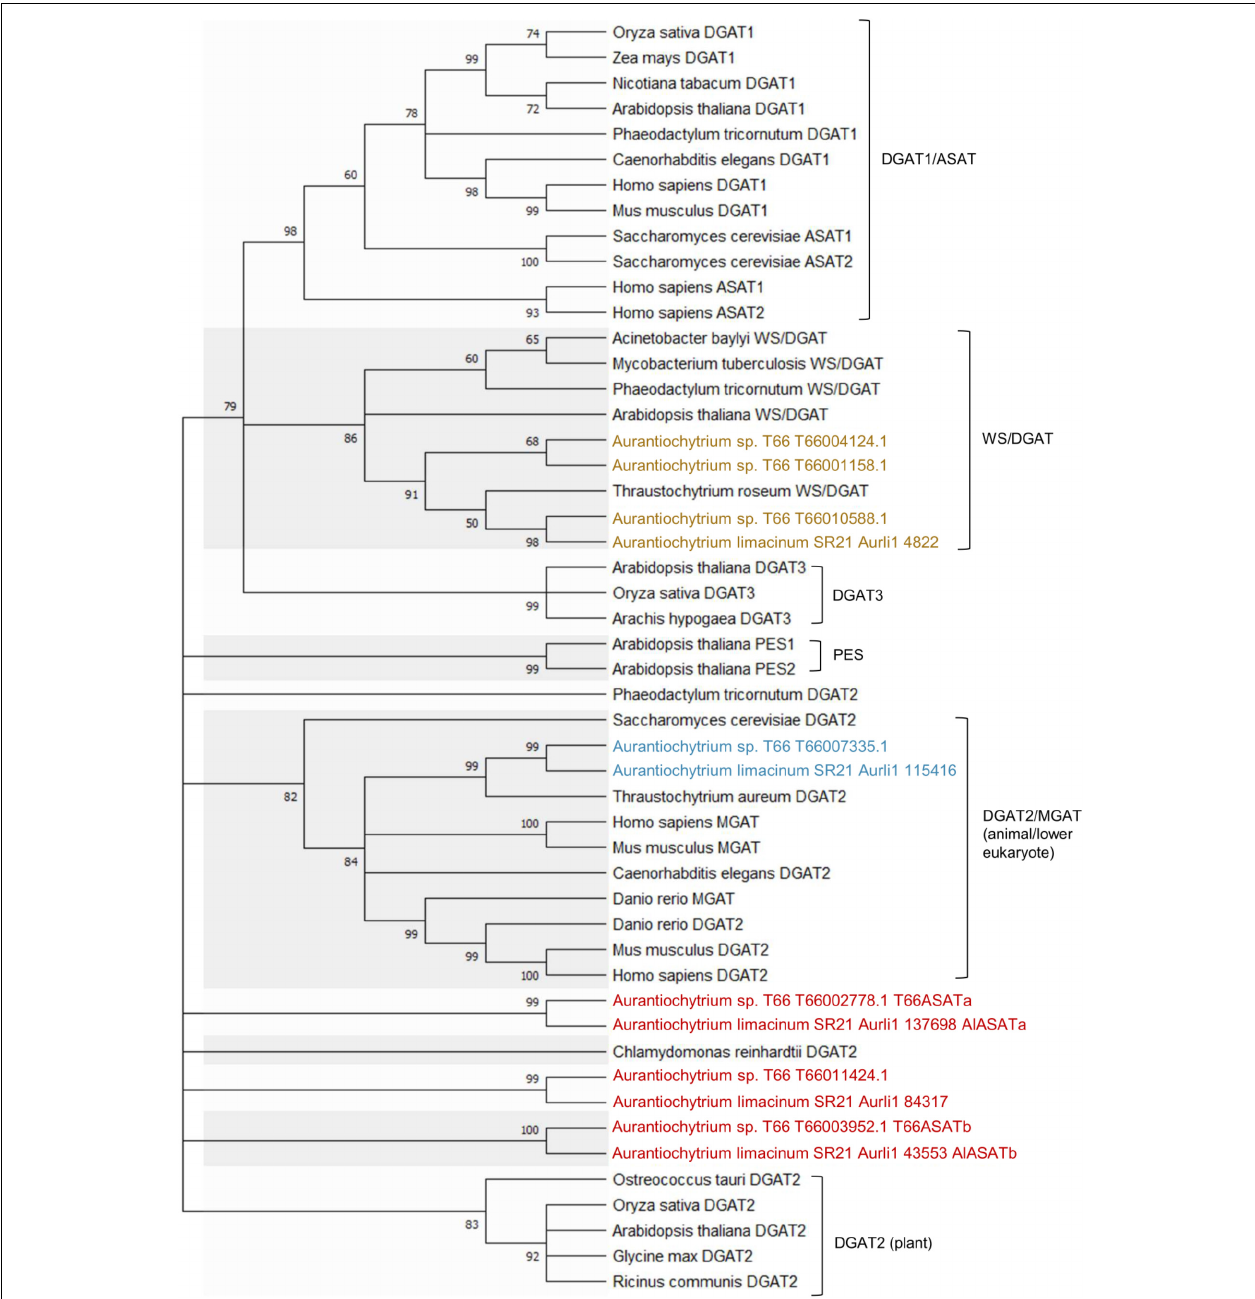
FIGURE 2 | Phylogenetic analysis of DGAT2s (blue), WS/DGATs (yellow), and DGAT2-like proteins (red) in T66 and SR21, compared to selected DGAT-like proteins from different organisms. Supplementary Table 5 provides the Genbank accession number for each protein. The percentage of replicate trees in which the associated taxa clustered together in the bootstrap test (1,000 replicates) are shown next to the branches, which were collapsed if the corresponding partitions reproduced in less than 50% bootstrap replicates.